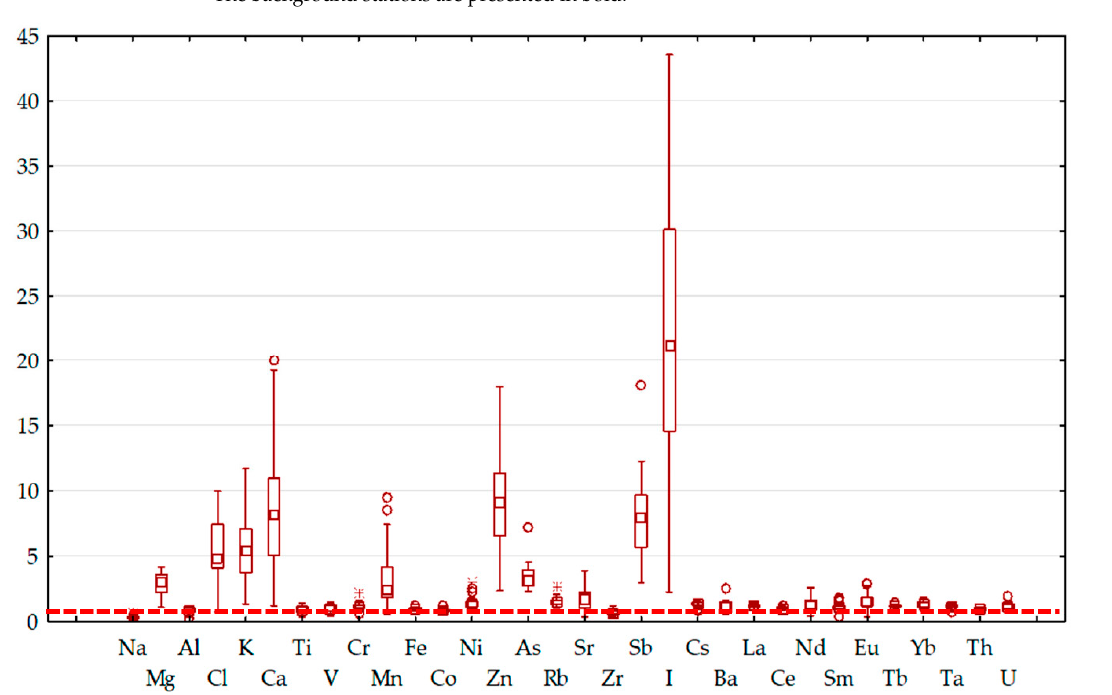
Figure 2. Enrichment factors (EF) of elements in all of the mosses from the studied area. Outliers were presented in red circles. The red dashed line corresponds to EF = 1. Table 4. Factor loadings of the analyzed elements in Crimean mosses.